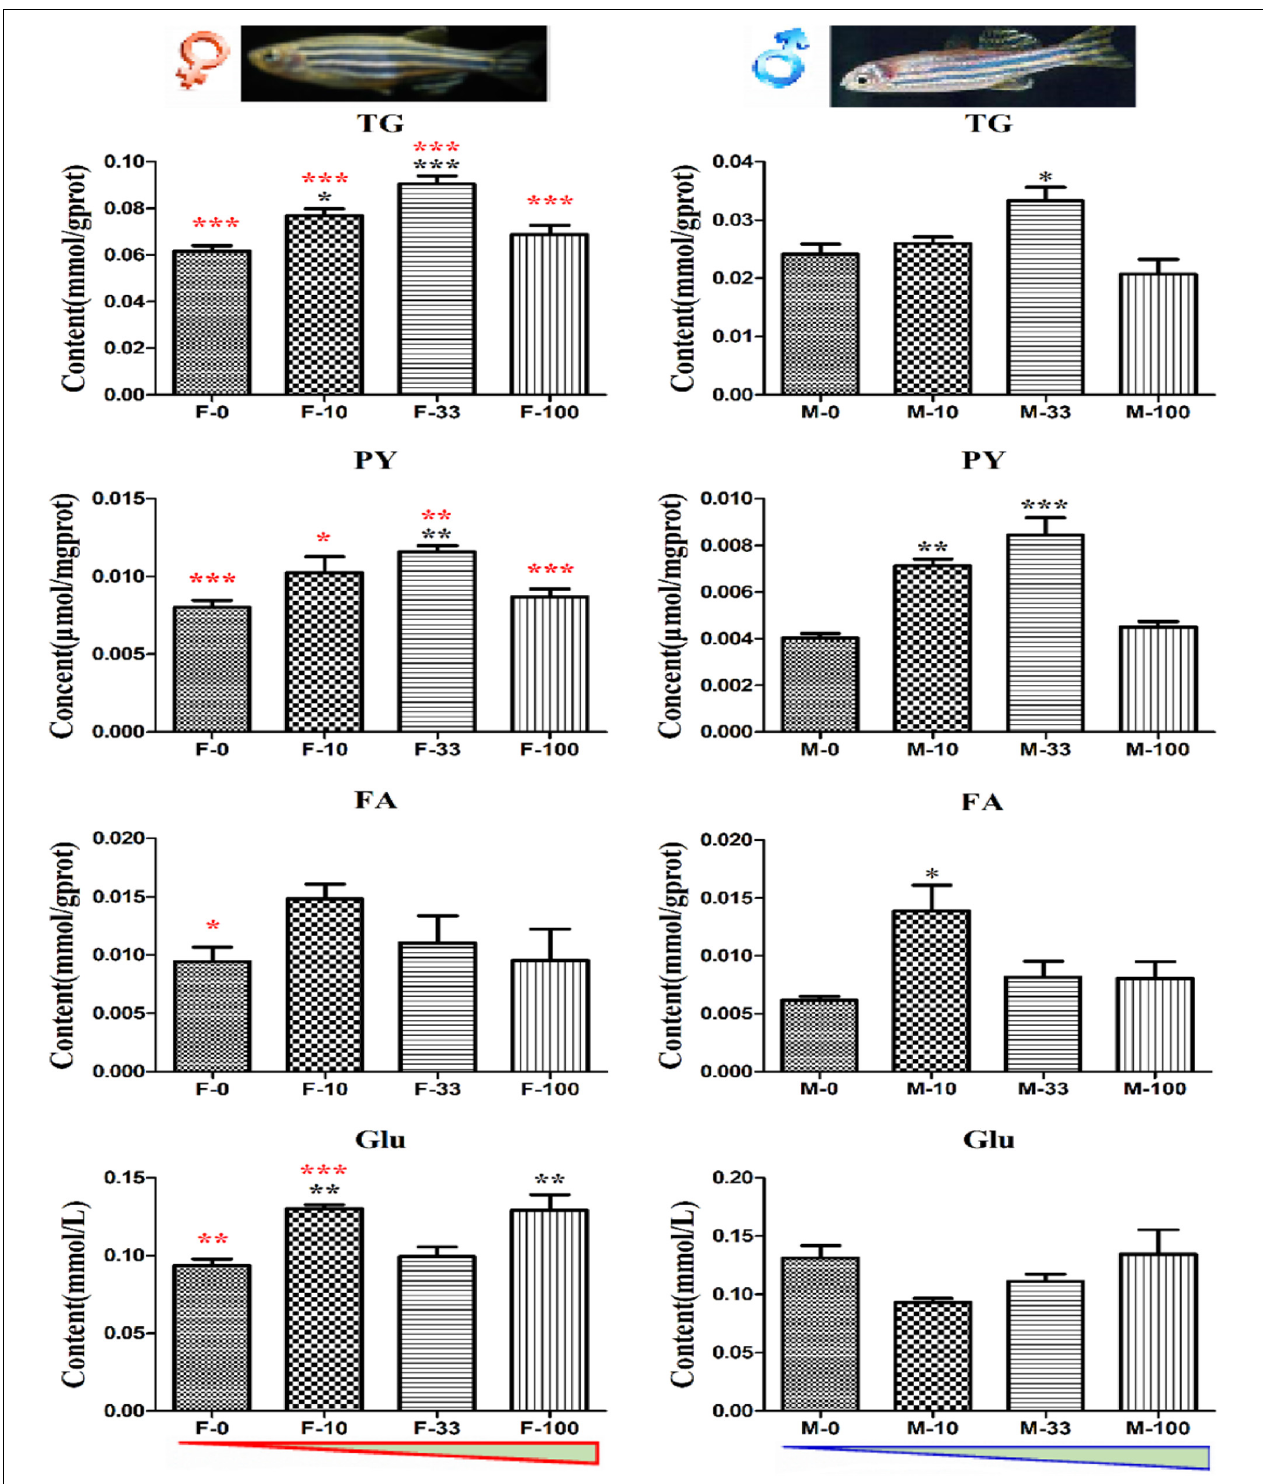
FIGURE 6 | The energy metabolites in DEHP exposed zebrafish intestines. The contents of metabolites TG, PY, FA, and Glu related to the energy cycle in treated zebrafish were measured with three biological replicates per group, and the black symbols *, **, and *** implied p < 0.05, 0.01, and 0.001, respectively. Moreover, the contents in both sex zebrafish were different, and the red color symbols *, **, and *** stand for the significant difference between female and male fish in the same groups. The red and blue triangles mean the increasing DEHP exposure concentration in female and male groups.